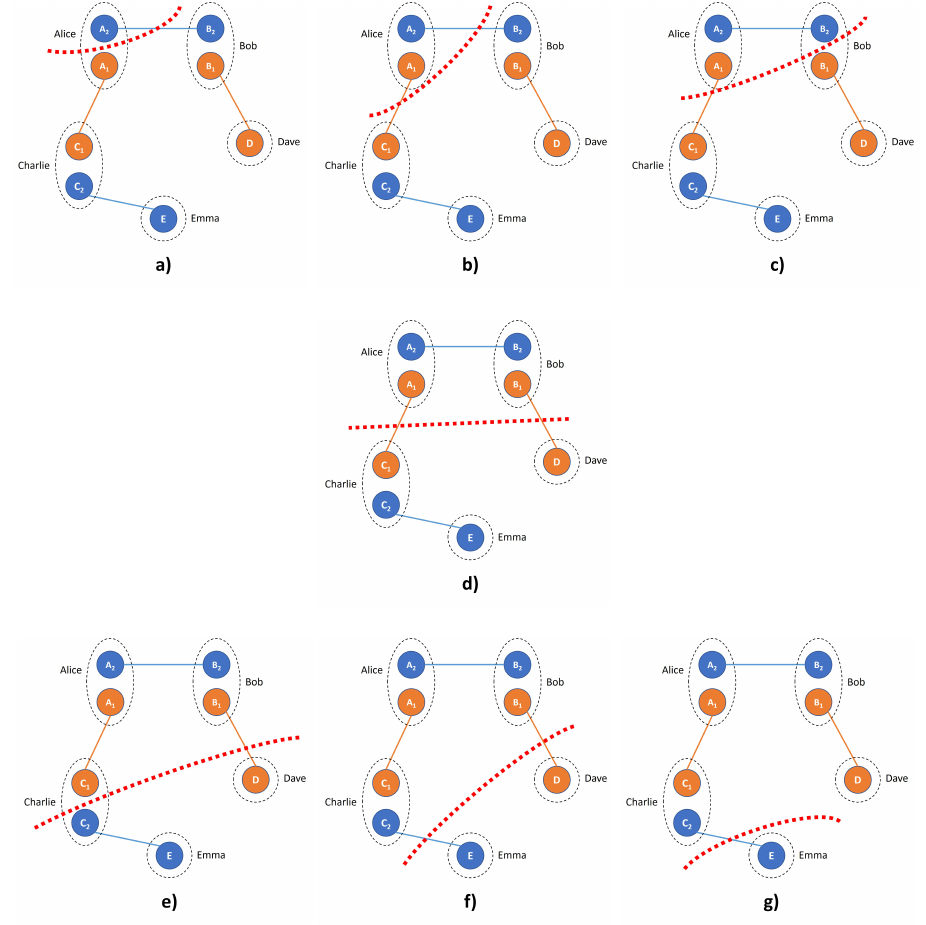
Figure 2. Bipartite cuts ρ i :8 − i with i = 1,2,. . .,7 of the eight-qubit system ρ are presented from ( a – g ). Cuts are denoted with dashed red lines. The ρ 4:4 cut shown in ( d ) is separable. Please see text for details.